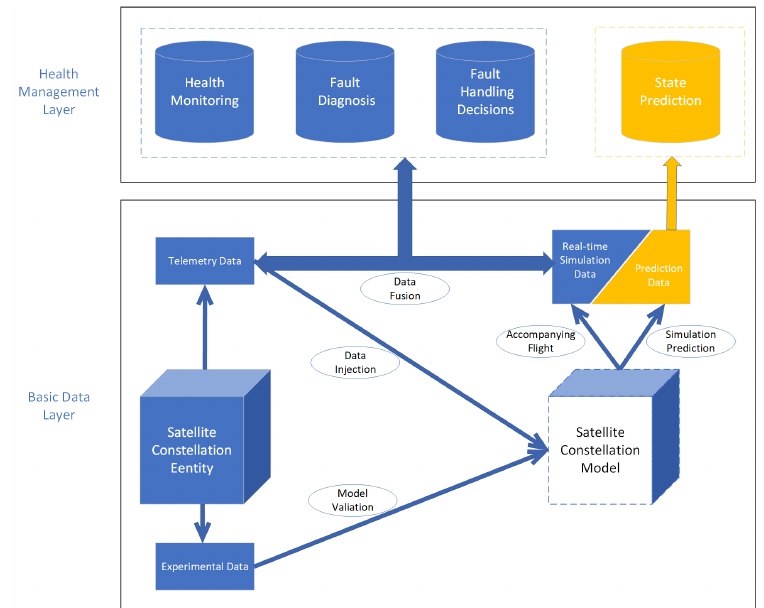
Figure 6. Health monitoring system architecture for satellite